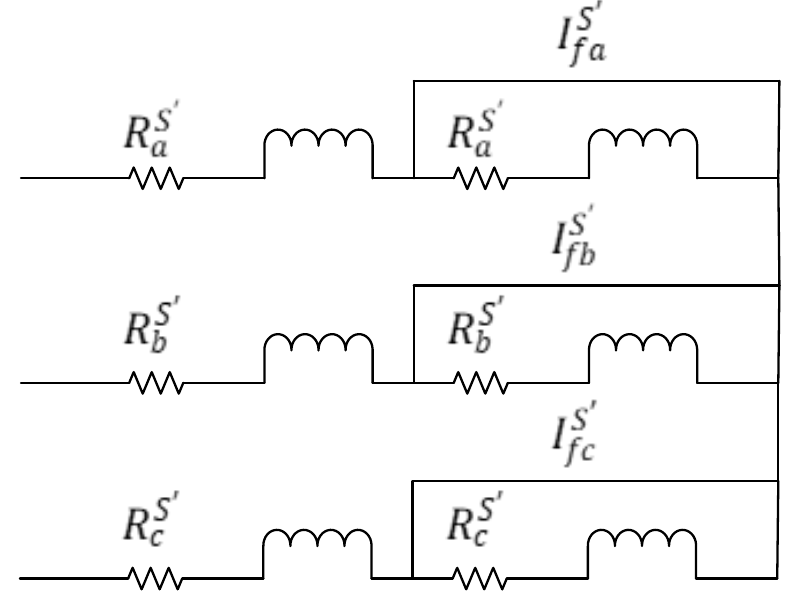
Figure 2. The equivalent circuit of PMSM with Inter-turn